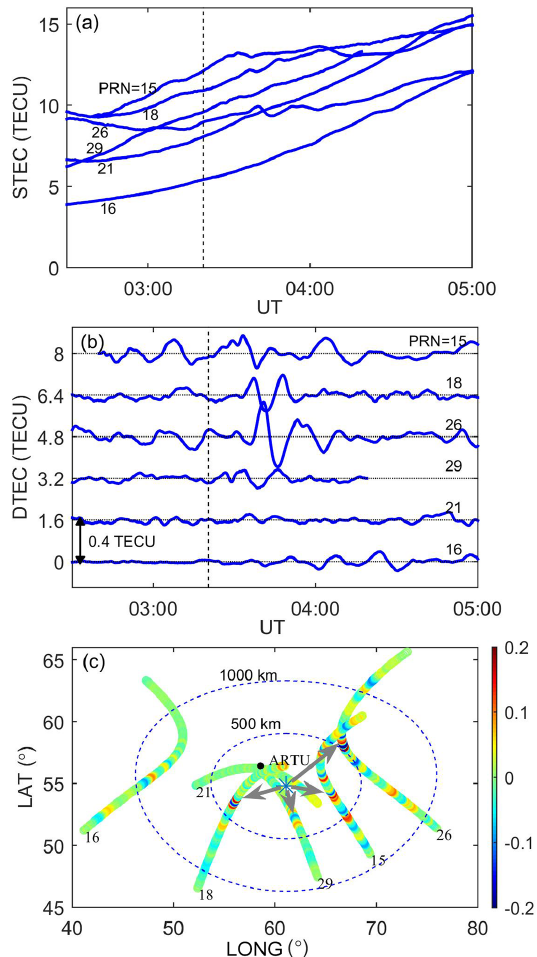
Figure 2. Ionospheric disturbances recorded at the ARTU GPS sta- tion on 15 February 2013. (a) Temporal TEC variation. (b) Tem- poral variation of the TEC perturbation. (c) Spatial distribution of the TEC perturbation. The GPS satellite PRNs corresponding to all TEC series are marked near each series. The vertical dotted lines in panels (a) and (b) mark the time of the meteorite blast (03:20UT). Curves in Panel (c) indicate the trajectories of the ionospheric pierce points, with the contours representing the amplitude of perturbation in TECUs. The asterisk in panel (c) marks the site of the mete- orite blast. Grey lines connect the blast site and the sites where TEC perturbations were recorded, with arrows denoting the propagation directions.